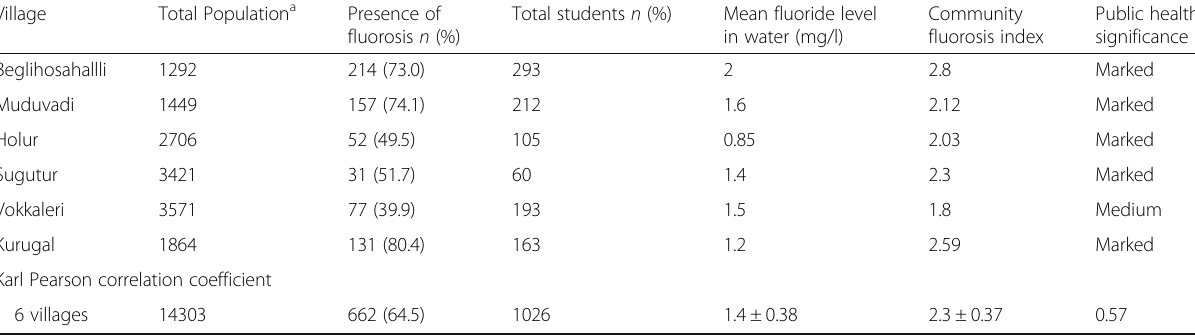
Table 2 Village-wise prevalence of dental fluorosis and Community Fluorosis index